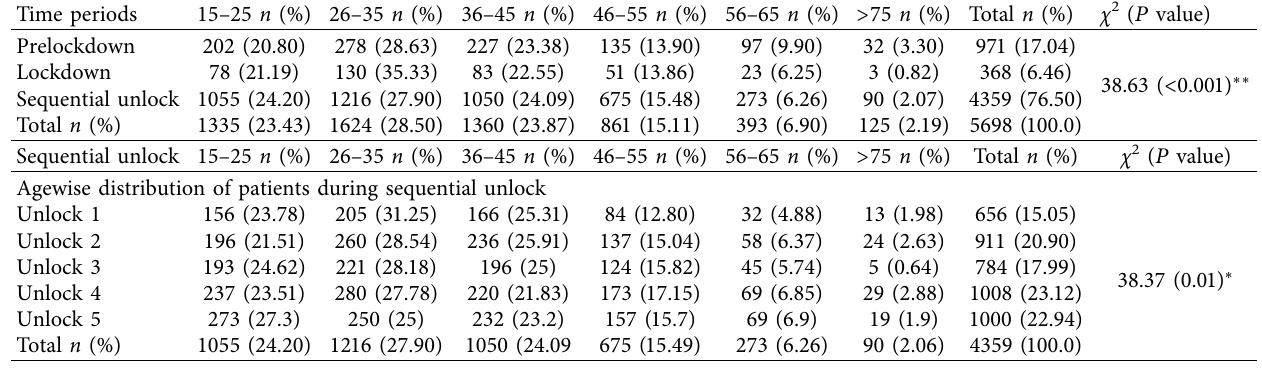
Table 2: Agewise distribution of patients during various time periods.